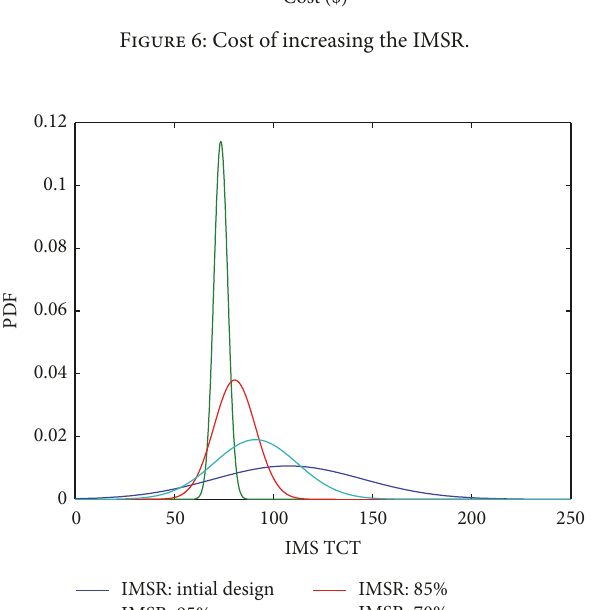
Figure 7: Distributions of the mean TCT at different